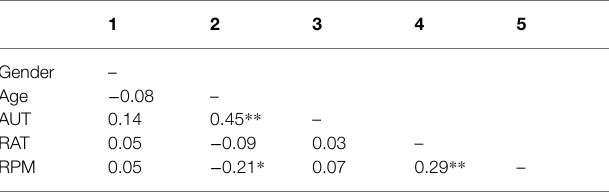
TABLE 2 | Correlations among the study